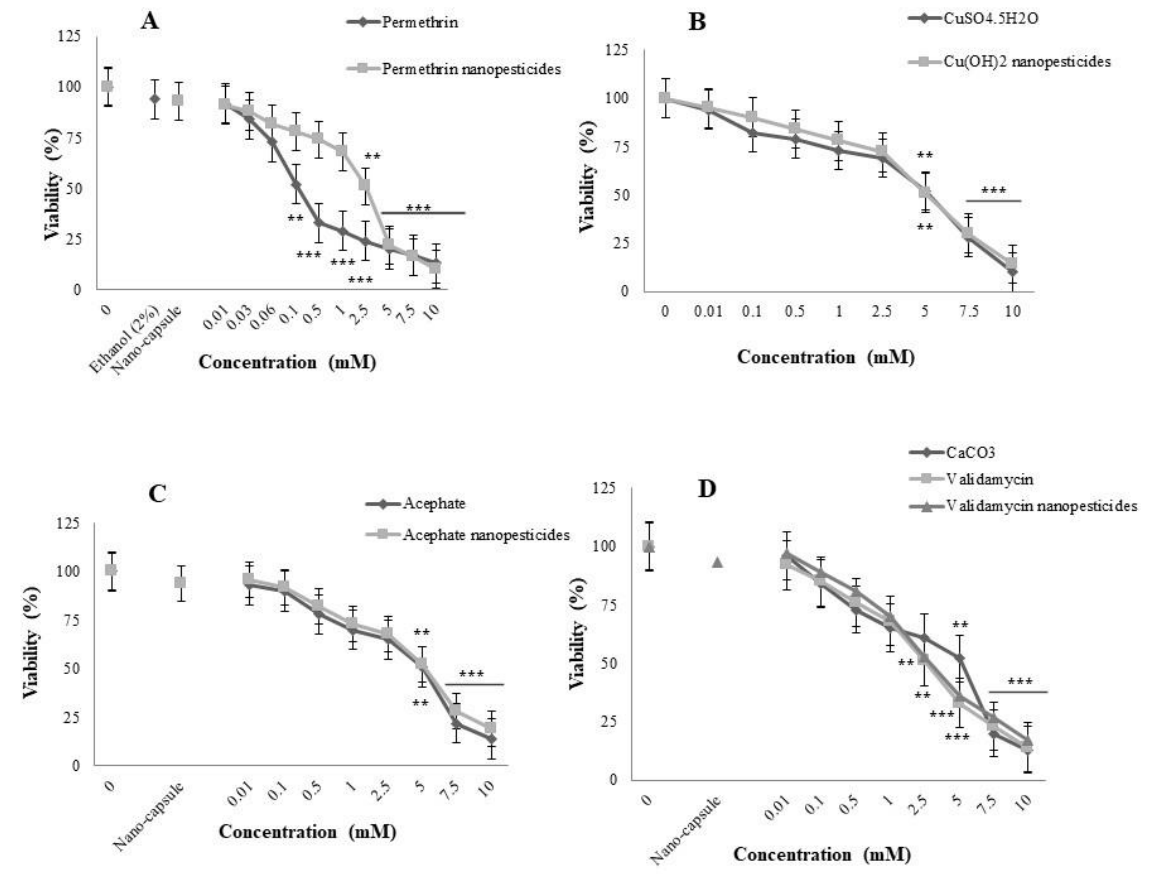
Figure 1. Toxicity of permethrin and permethrin nanopesticides ( A ), CuSO 4 · 5H 2 O and Cu(OH) 2 nanopesticides ( B ), acephate and acephate nanopesticides ( C ), and validamycin and validamycin nanopesticides ( D ) in D. melanogaster . Toxic effects were measured as loss of viability (egg-to-adult survival) relative to the control values. N = 5 vials per concentration, with 50 eggs per vial. The statistical approach was analyzed using the Mann–Whitney U -test; ** p ≤ 0.01, *** p ≤ 0.001 compared to controls.